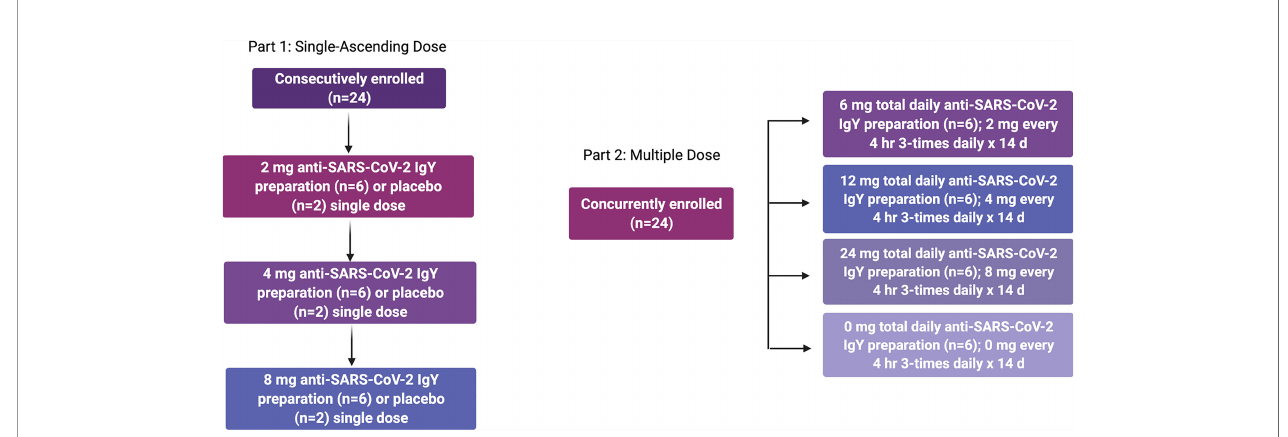
FIGURE 1 | Design of phase 1 human single-ascending and multiple-dose